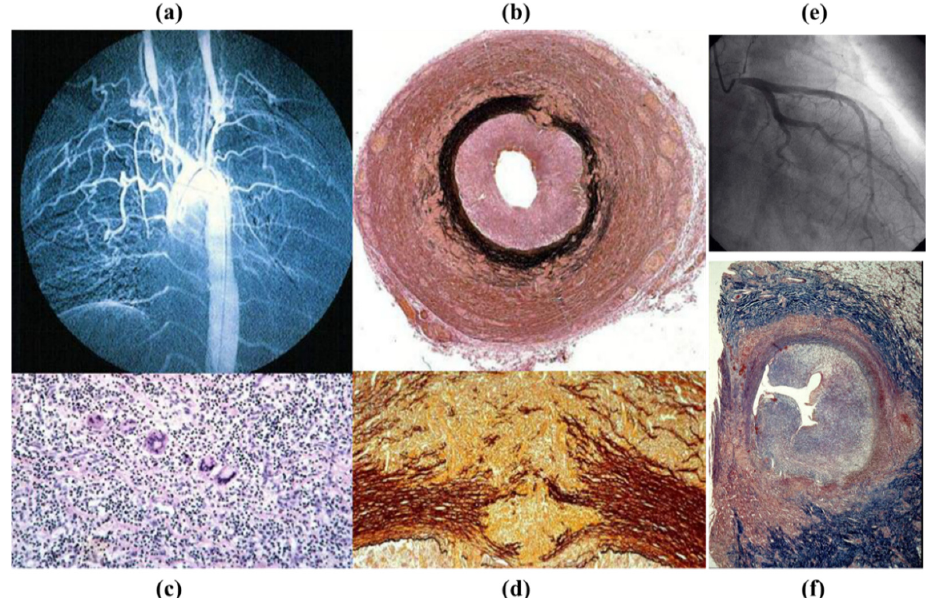
Figure 26. Takayasu arteritis in a 17-year-old girl. ( a ) Angiogram with typical obstruction of the brachiocephalic arteries. ( b ) Cross-section of the left carotid artery: note the severe stenosis of the lumen and the thickness of the adventitia (Weigert Van Gieson stains). ( c ) Giant cell inflammatory infiltrates (hematoxylin-eosin stain). ( d ) Necrotizing angiitis with disruption of the tunica media (close up of ( b )). ( e ) Left coronary artery stem stenosis by selective coronary angiography with obstructed ostium. ( f ) Corresponding histology (Weigert Van Gieson